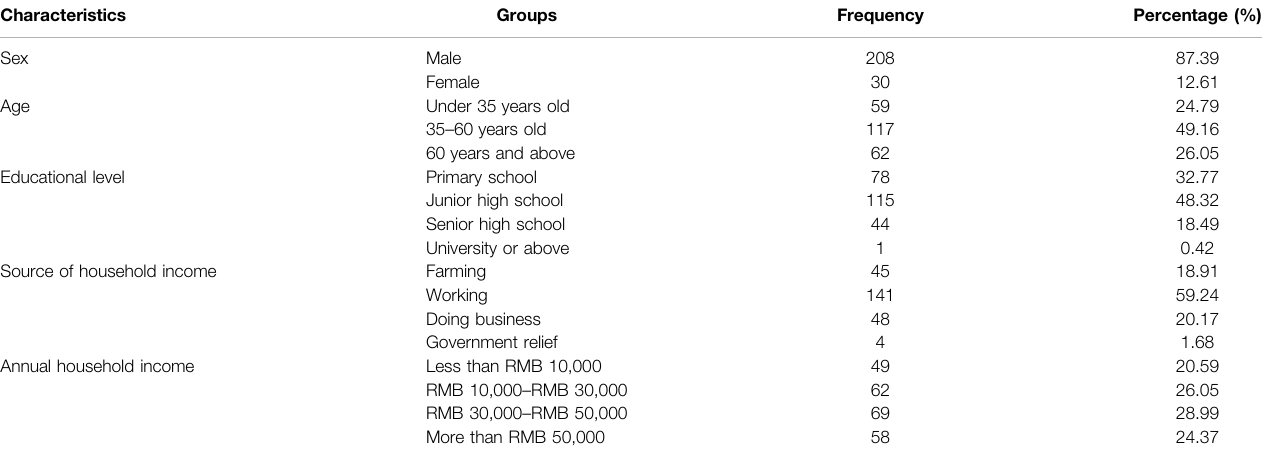
TABLE 3 | Descriptive analysis of sample